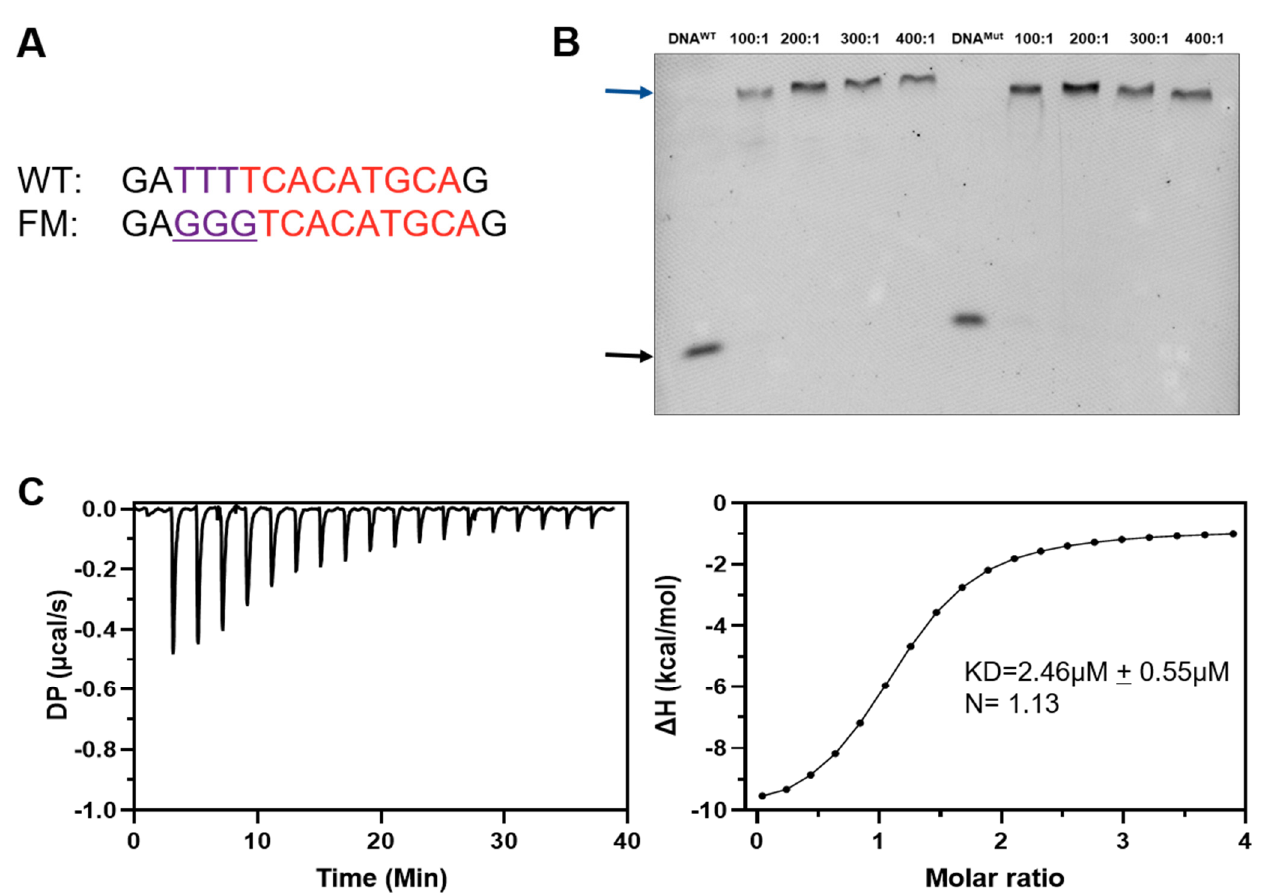
Figure 5. Interaction of the native version of Ino2p DBD /Ino4p DBD and promoter DNA fragments (wild-type and flanking-mutant): ( A ) Sequence alignment of wild-type and flanking-mutant promoter sequence; ( B ) EMSA for Ino2p DBD /Ino4p DBD (WT) and promoter DNA (WT and FM). The black arrow designates DNA alone, while the blue arrow denotes the Ino2p DBD /Ino4p DBD /DNA ternary complex. The effect of the flanking-mutated sequence was validated with three independent experiments; ( C ) Quantitative interaction analysis of Ino2p DBD /Ino4p DBD (WT) and flanking mutant promoter DNA.